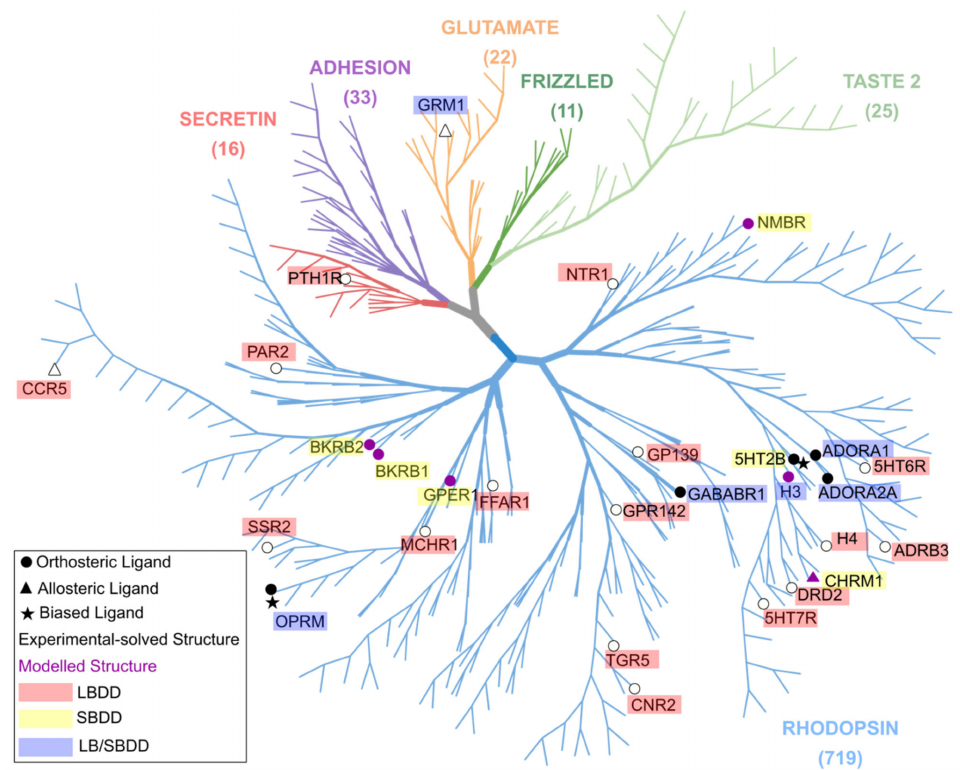
Figure 6. A phylogenetic tree representing all the receptors discussed in this review, and their as- sociated applications of pharmacophore modeling in GPCR drug discovery. Node labels indicate the Uniprot gene name of the receptor and are colored according to the method used to gener- ate the 3D pharmacophore (red, ligand-based; yellow, structure-based; blue, both methods). The shape of the node implies the ligand type studied in each case (circle, orthosteric ligand; triangle, allosteric ligand; star, biased ligand). Circles, triangles, and stars are colored according to the origin of the 3D receptor structure (black, experimentally solved structure; purple, modeled structure; white, no structure involved). The GPCR tree was produced as follows. First, canonical fasta files of all human GPCR receptors (826 receptors in total, but olfactory receptors are not shown on the tree for simplicity and aesthetics) were downloaded from the Uniprot database [153]. Then, the above fasta files were used to generate a phylogenetic tree file by Clustal Omega (default set- ting) [154]. Finally, the tree was displayed and annotated with iTOL [155]. The tree layout was designed according to [156]. Uniprot gene names of the receptors are as follows: NMBR = Bombesin Receptor 1; BKBRB1 and BKBRB2 = Bradykinin Receptors 1 and 2, respectively; ADRB3 = β 3- adrenergic Receptor; CNR2 = Cannabinoid Receptor 2; TGR5 = G Protein-Coupled Bile Acid Receptor; GPER = G Protein-Coupled Estrogen Receptor; H3 = Histamine H 3 Receptor; MCHR1 = Melatonin- Concentrating Hormone Receptor-1; NTR1 = Neurotensin Receptor type 1; PAR2 = Protease-activated Receptor 2; OPRM = µ -Opioid Receptor; CCR5 = Chemokine Receptor 5; GRM1 = Metabotropic Glutamate Receptor 1; PTH1R = Parathyroid Hormone-1 Receptor; DRD2 = Dopamine D 2 Receptor; 5HT7R = Serotonin 5-HT 7 Receptor; FFAR1 = G Protein-Coupled Receptor 40; H4 = Histamine H 4 Receptor; SSR2 = Somatostatin Receptor Subtype-2; 5HT2B = Serotonin 5-HT 2B Receptor; GPR139 = G protein-Coupled Receptor 139; ADORA1 and ADORA2 = Adenosine A 1 and Adenosine A 2A Recep- tors, respectively; GABABR1 = GABA B